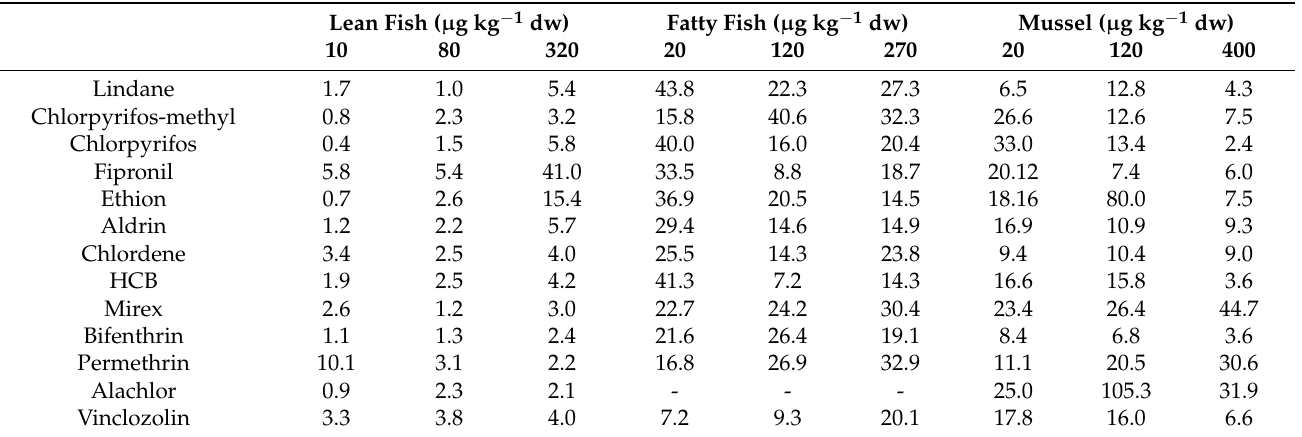
Table 2. RSD, referring to repeatability of the analysis method in three concentrations for the lean fish, fatty fish and bivalve matrices.